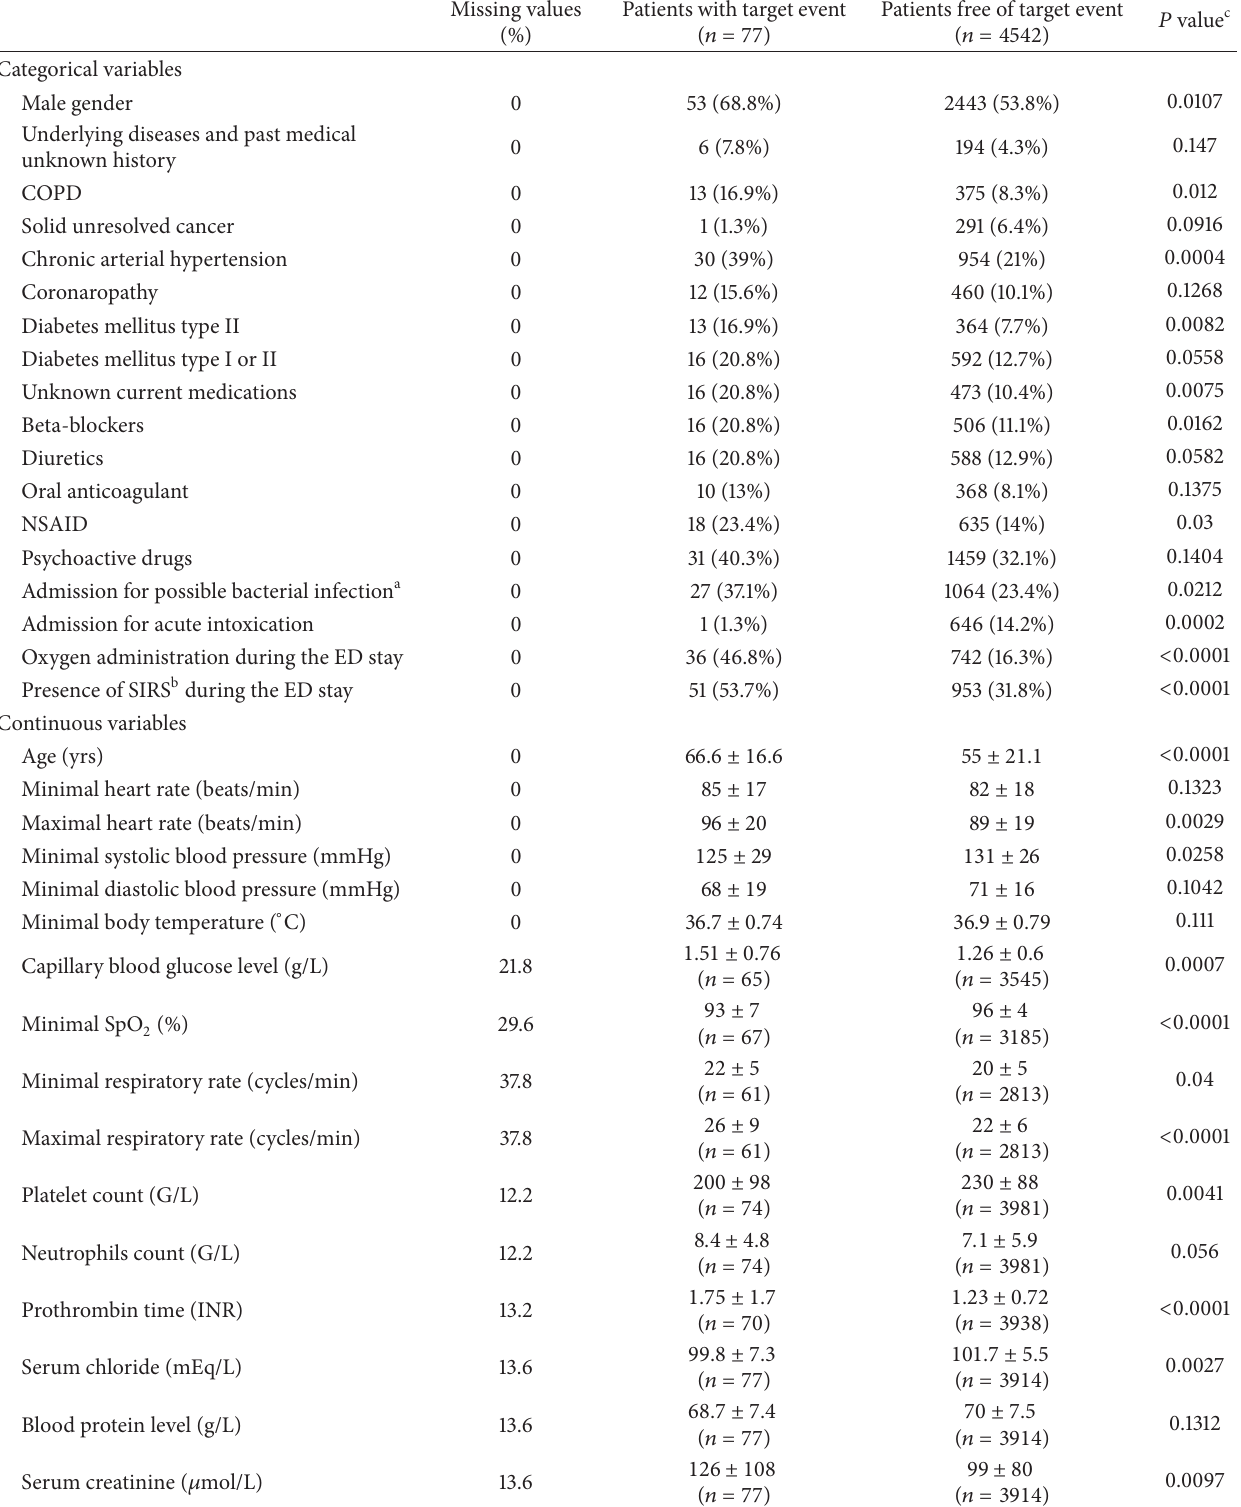
Table 2: Clinical and biological variables linked to the target event (death or unplanned ICU or HDU admission during the first 15 days of